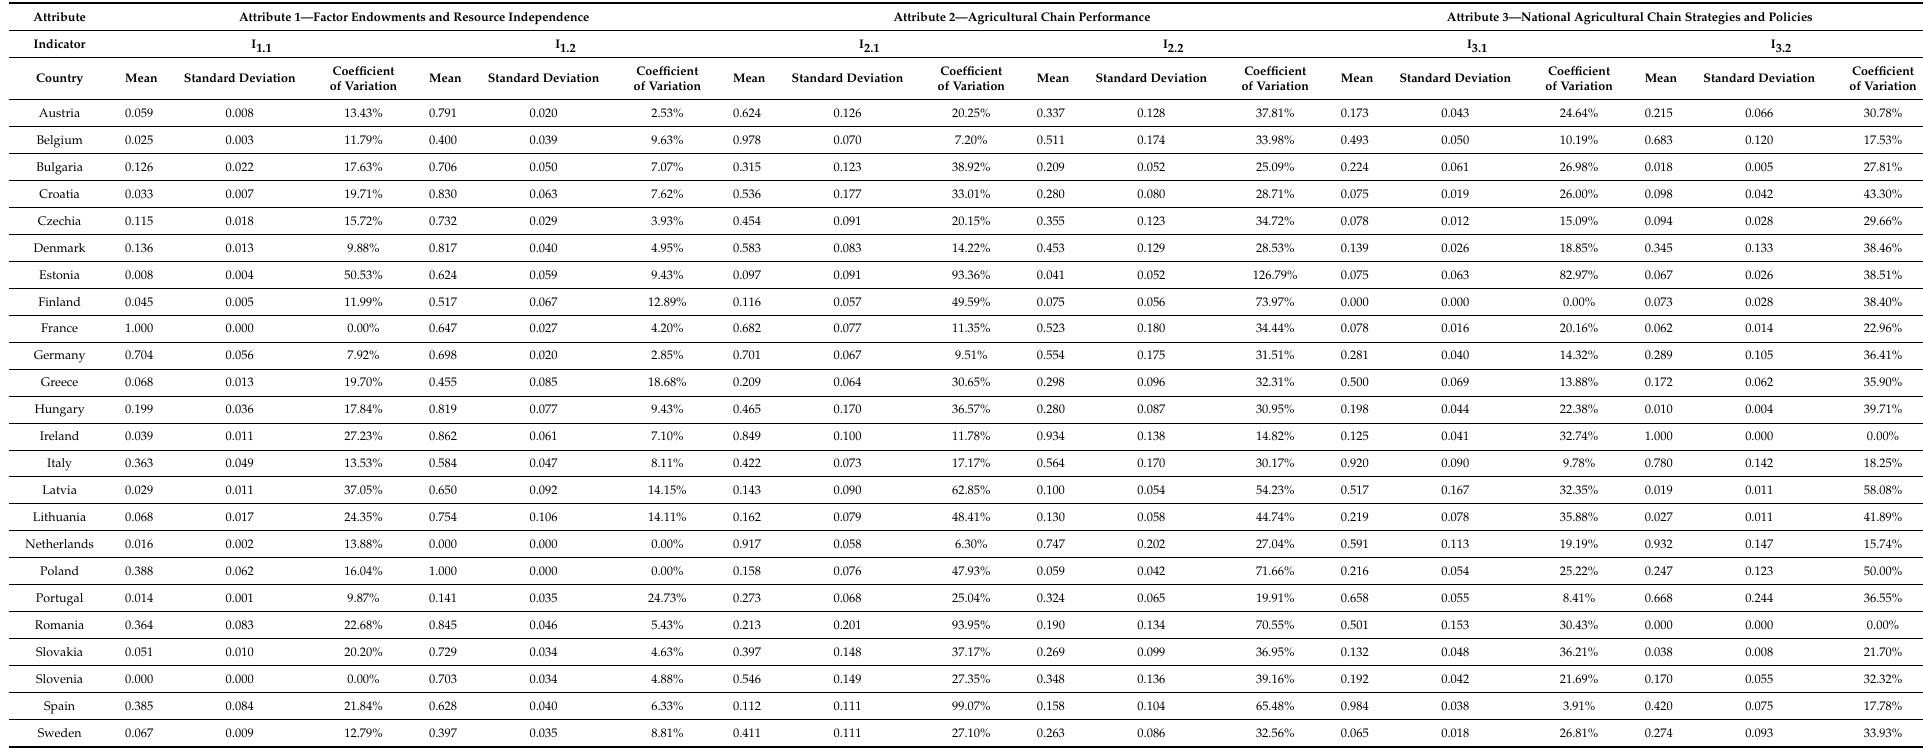
Table 3. Descriptive statistics of the normalized indicators used to construct the sustainable economic competitiveness index ( n = 10 years;